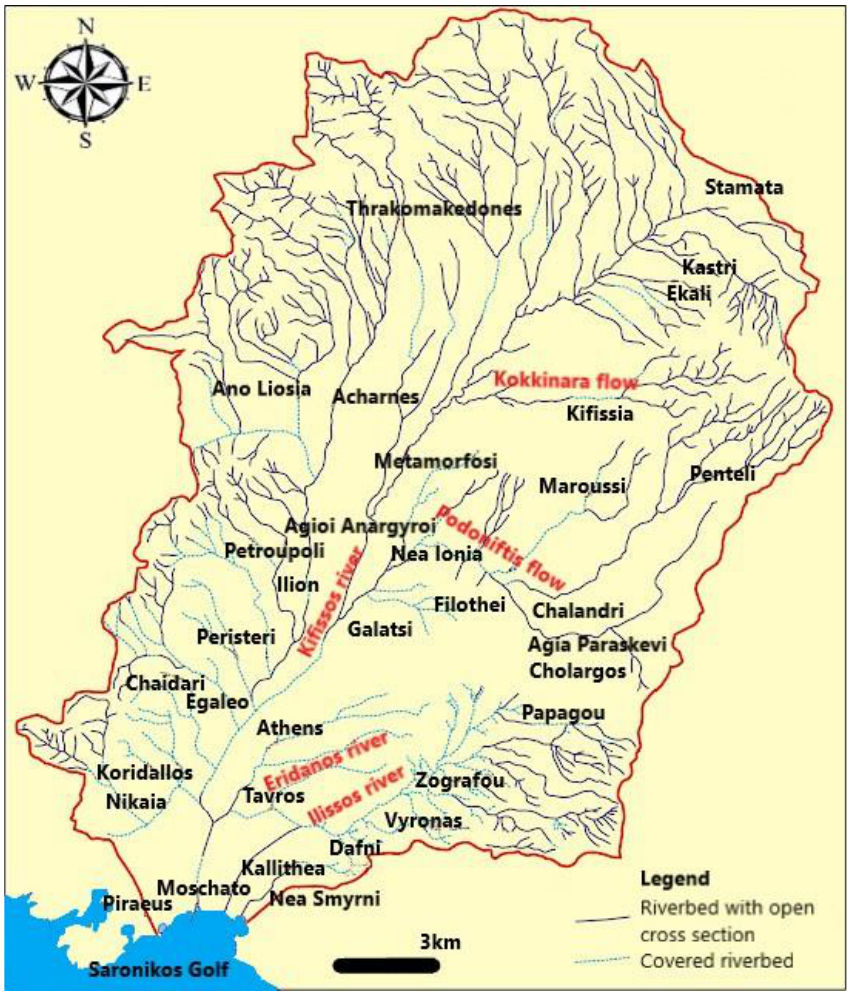
Figure 4. Map showing the hydrographic networks of Attica [30], modified by